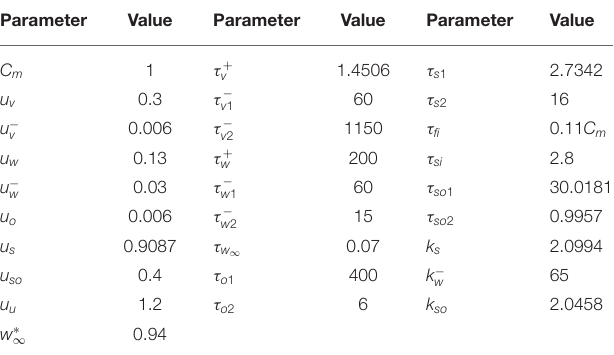
TABLE 1 | The parameters of the Bueno-Orovio-Cherry-Fenton (BOCF) model, modified to represent cardiac tissue with significant fibrosis.